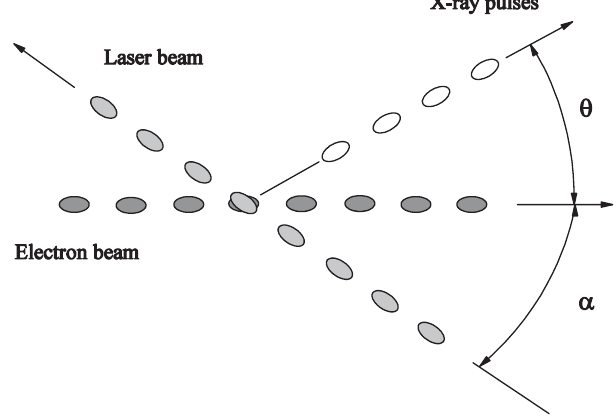
FIG. 1. LCS interaction geometry, (cid:2) is the crossing angle,